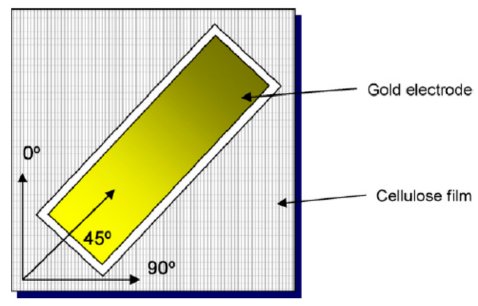
Figure 4. Orientation of cellulose film and schematic of EAPap [40].